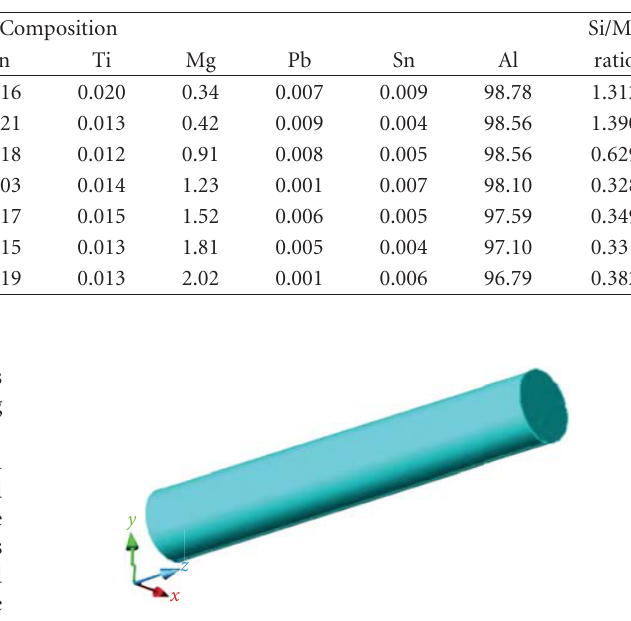
Figure 1: Standard electrochemical corrosion